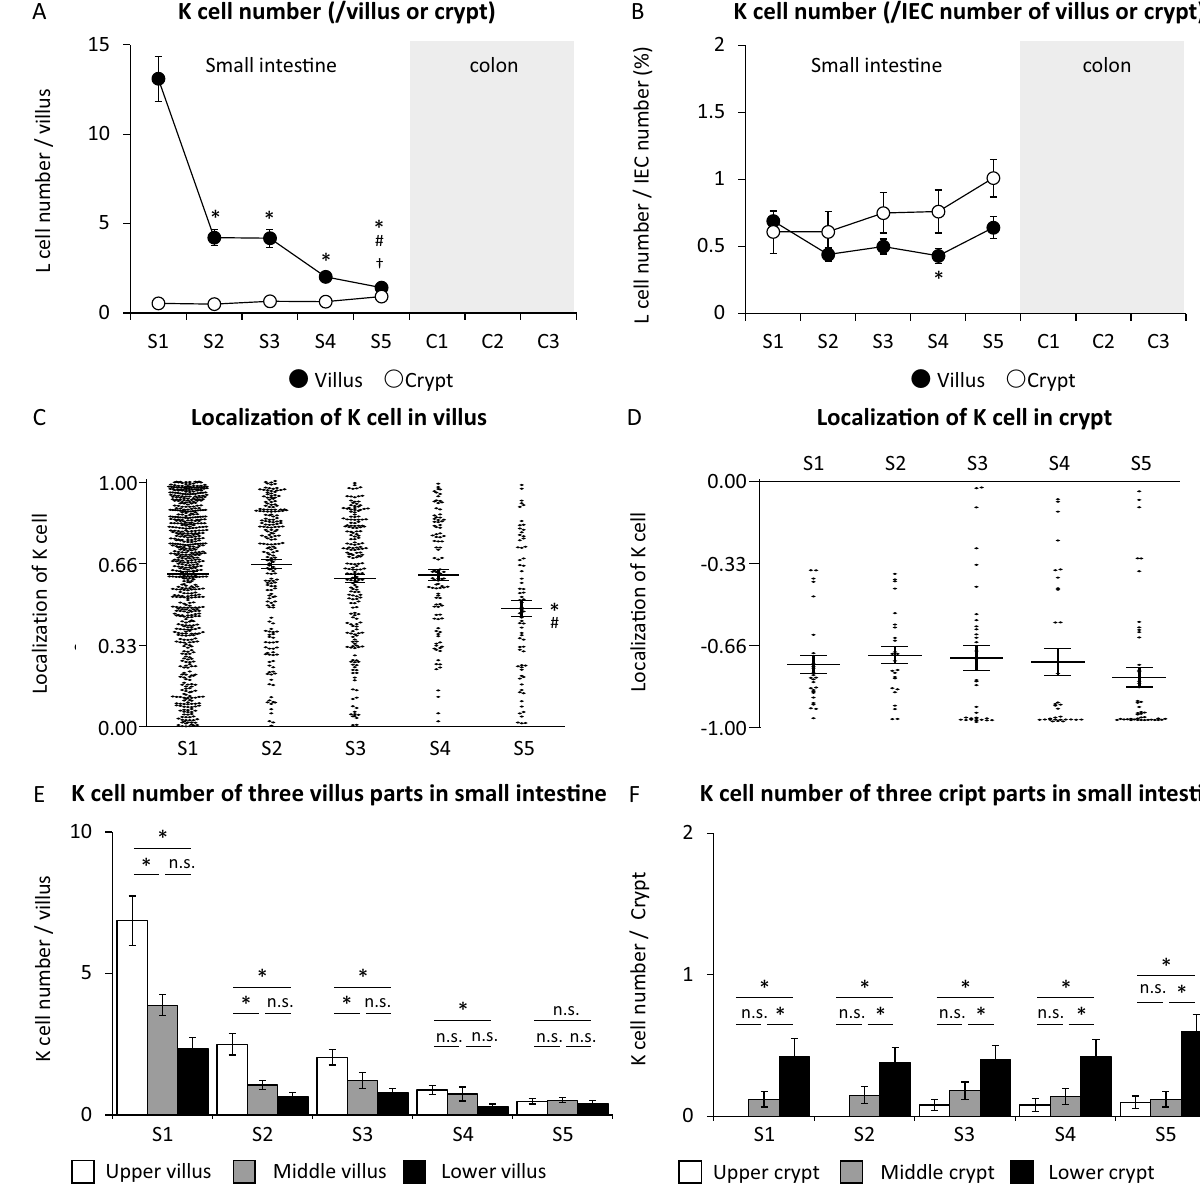
Figure 6. K cell number and localization in villi or crypts of Villin1-Tomato+ GIP-GFP mice. ( A ) K cell number per villus or crypt and ( B ) K cell number per intestinal epithelial cell (IEC) number in each section of villus and crypt (n = 50 villi and crypts in 5 mice). Black circle and white circle show the number and the percentage of K cells in villus and crypt, respectively. All plots and the average value of K cell localization in ( C ) 50 villi and ( D ) 50 crypts of each section. ( E ) K cell number in the upper, middle, and lower villus of small intestine. ( F ) K cell number in the upper, middle, and lower crypt of small intestine. (n = 50 villi or crypts in 5 mice). *P < 0.05 vs. S1, # P < 0.05 vs. S2, † P < 0.05 vs. S3. n.s. not